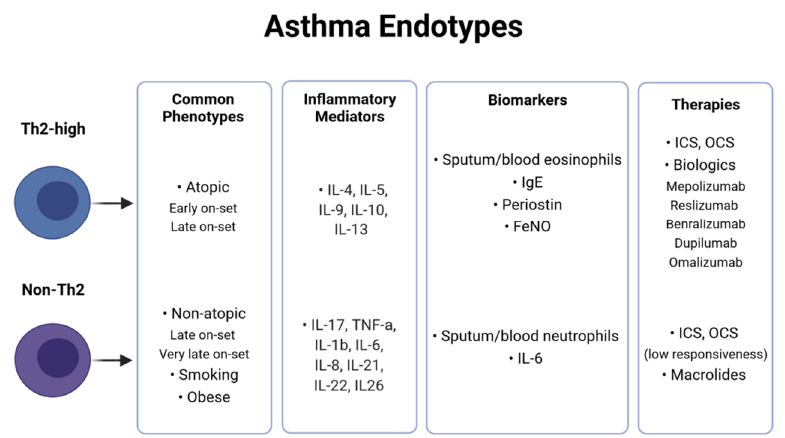
Figure 1. Main features of asthma endotypes. FeNO: fractional exhaled nitric oxide; IgE: immuno- globulin E; IL: interleukin; ICS: inhaled corticosteroids; OCS: oral corticosteroids.